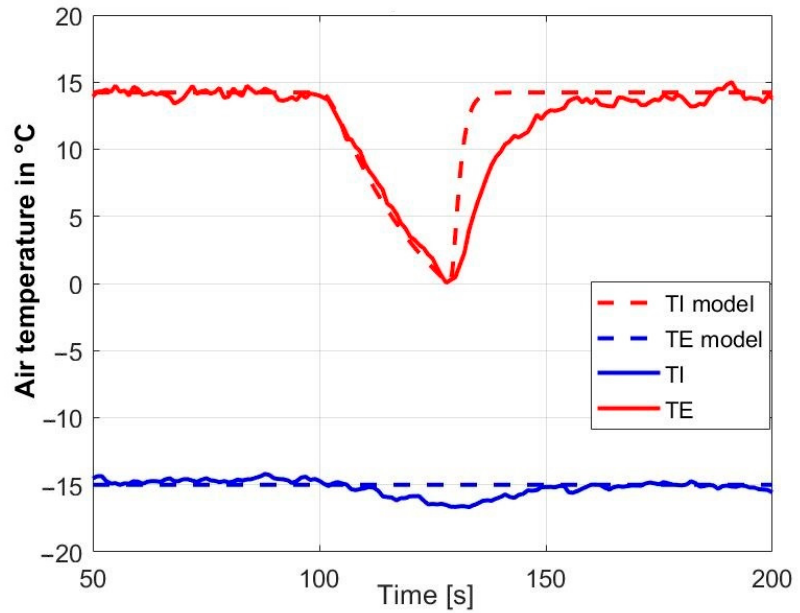
Figure 8. Diagram of comparison between model and experimental data for a number of sections n = 5 for air temperatures.